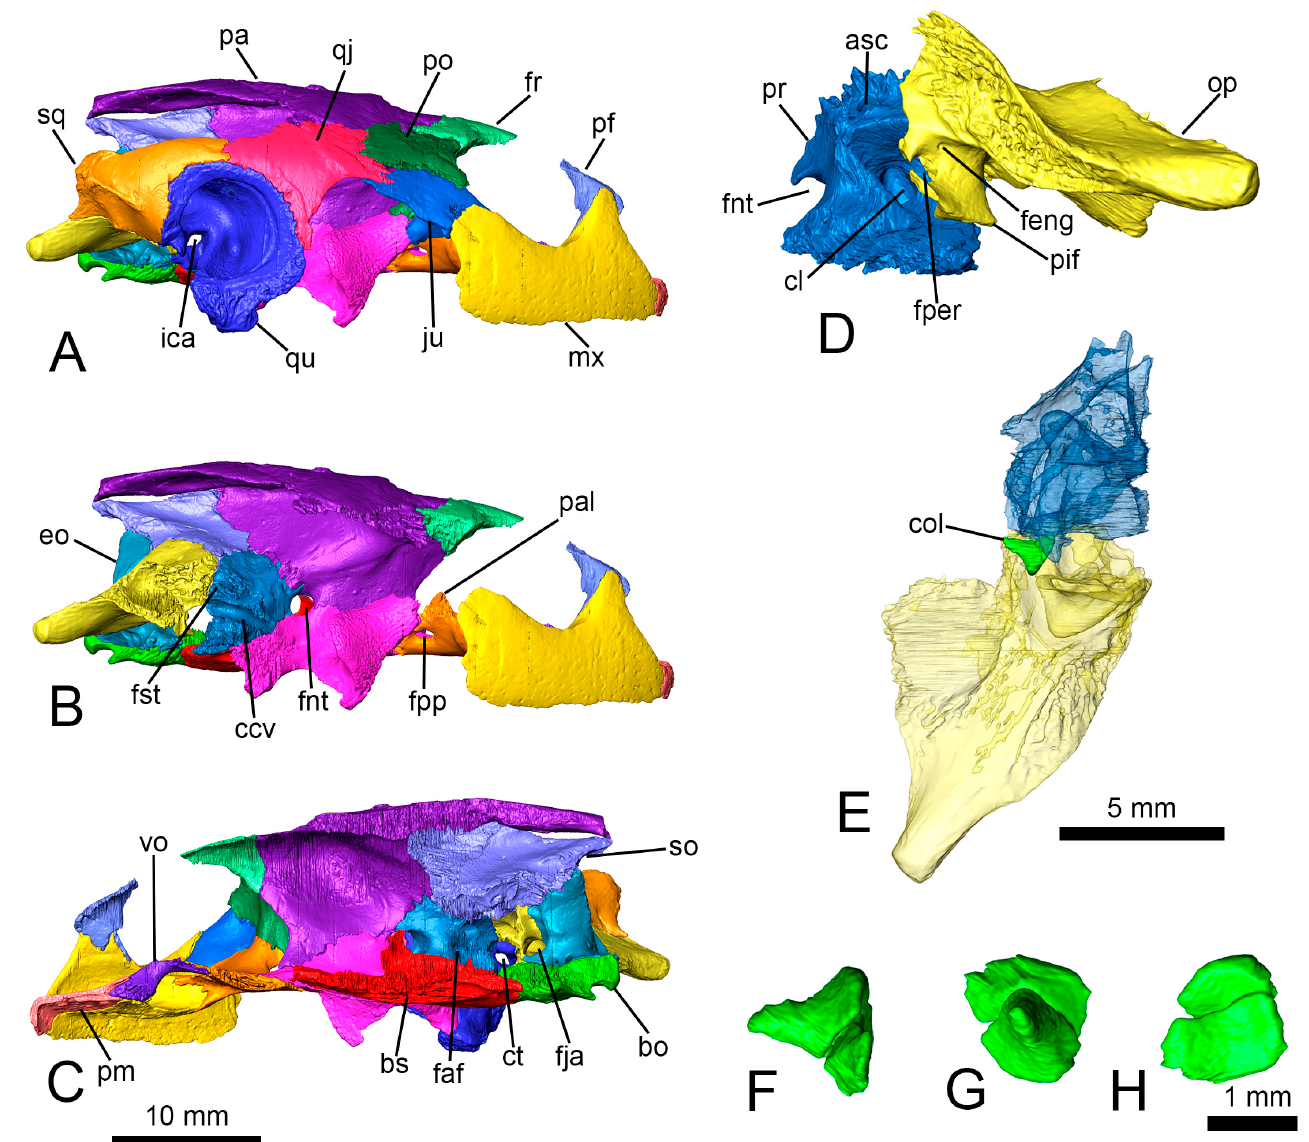
Figure 3. FR 4922, three-dimensional reconstruction of the skull of the holotype of Euraxemys essweini (Euraxemydidae) from the Albian of Araripe Basin in Brazil showing the right bones and medial odd bones virtually removing the sediment in right lateral ( A , B ) and medial ( C ) views. Each bone is shown with a different color. The jugal, the postorbital, the quadratojugal, the quadrate, and the squamosal have been virtually removed ( B ) to show the inner region of the temporal fossa. Prootic and opisthotic ( D , E ) in posterolateromedial ( D ) and ventral ( E ) views. The position of the columella auris is shown between the prootic and the opisthotic ( E ). Columella auris ( F – H ) in dorsal ( F ), lateral ( G ), and medial ( H ) views.